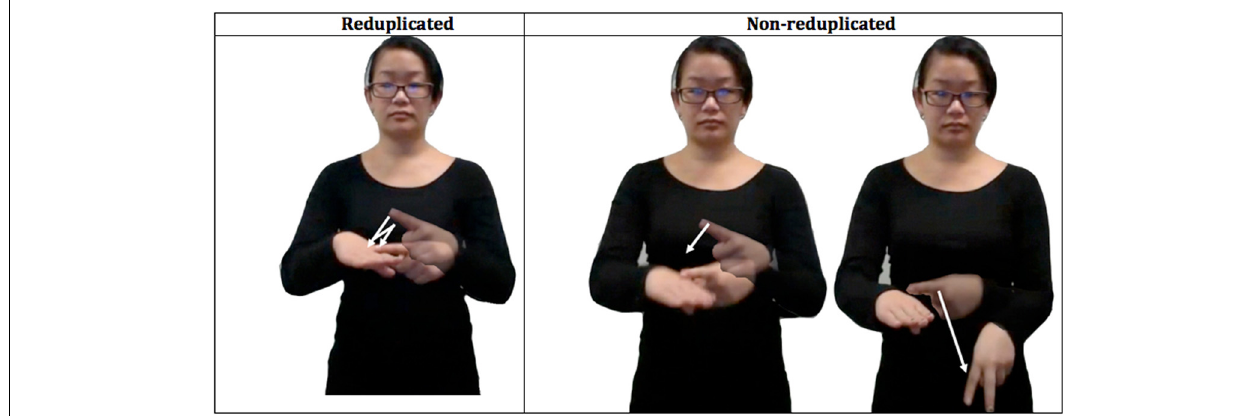
FIGURE 1 | An illustration of the novel signs used in Experiment 1.